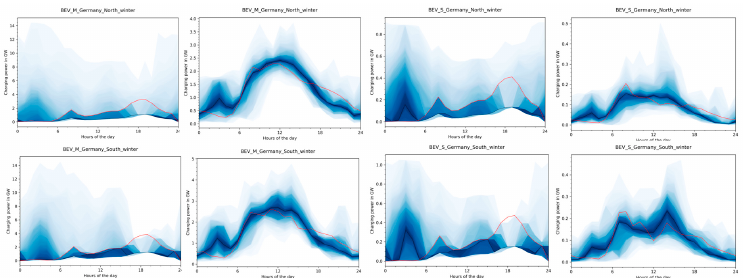
Figure A6. Daily probability distributions for total charging (controlled and uncontrolled) of medium and small sized BEV fleets in Northern Germany (top row) and Southern Germany (bottom row) in winter hours (1–2160 and 7920–8760). The first and the third column show S1 results and the second and third column show S2 results. A case of completely uncontrolled charging is shown as red line.